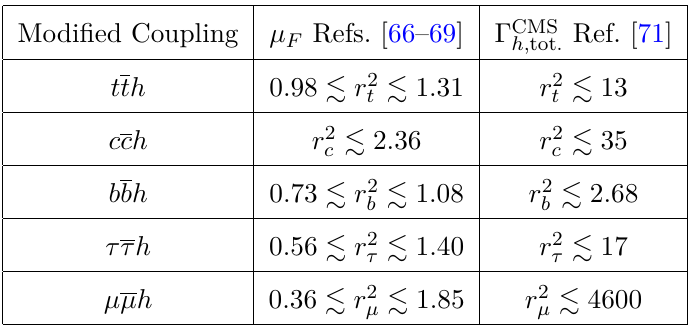
Table 7 . 95% C.L. limits on r 2 after χ 2 fits to data on the Higgs signal strength from refs. [66–69] ψ in the second column, and using the total Higgs decay width from ref. [71] in the third column, when NP modifies only a single fermion-Higgs coupling at a